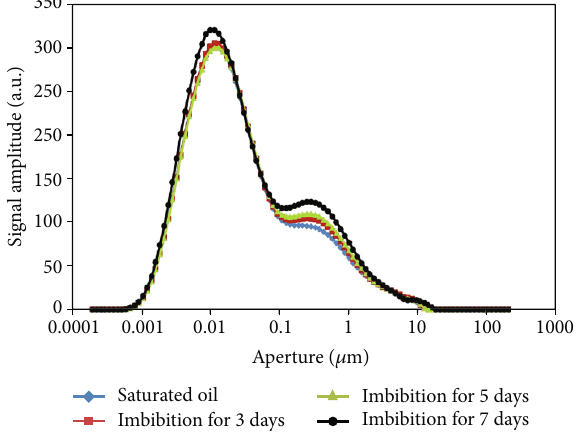
Figure 8: NMR T2 spectrum curve of core